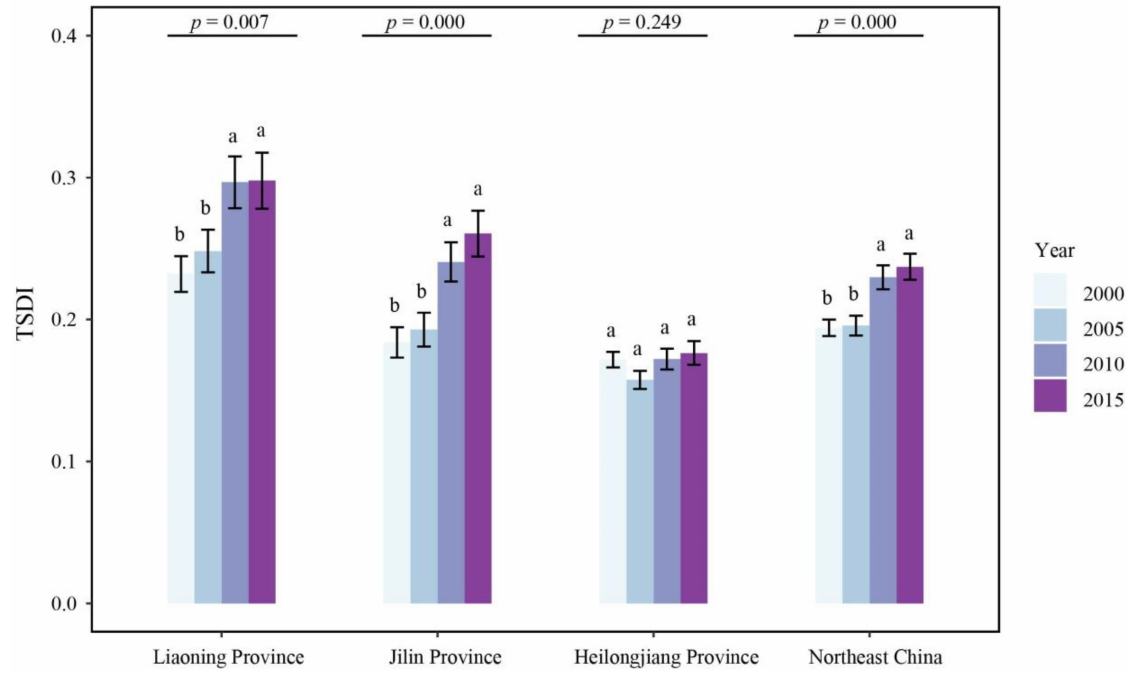
Figure 4. Changes in TSDI in Northeast China. Note: p < 0.05 means significant difference. There is no significant difference between the same letters in different years (Tukey’s post-hoc test, p >